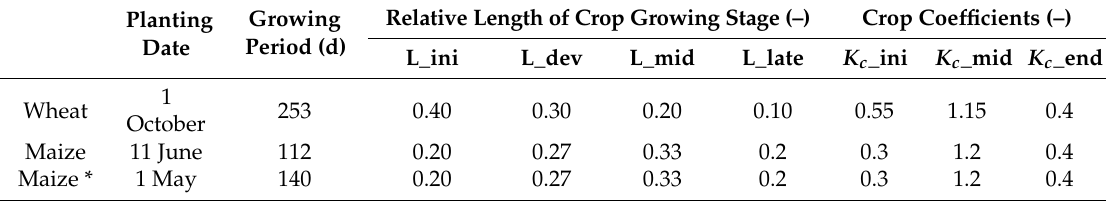
Table 2. Crop characteristics for winter wheat and maize in the Haihe River Basin.